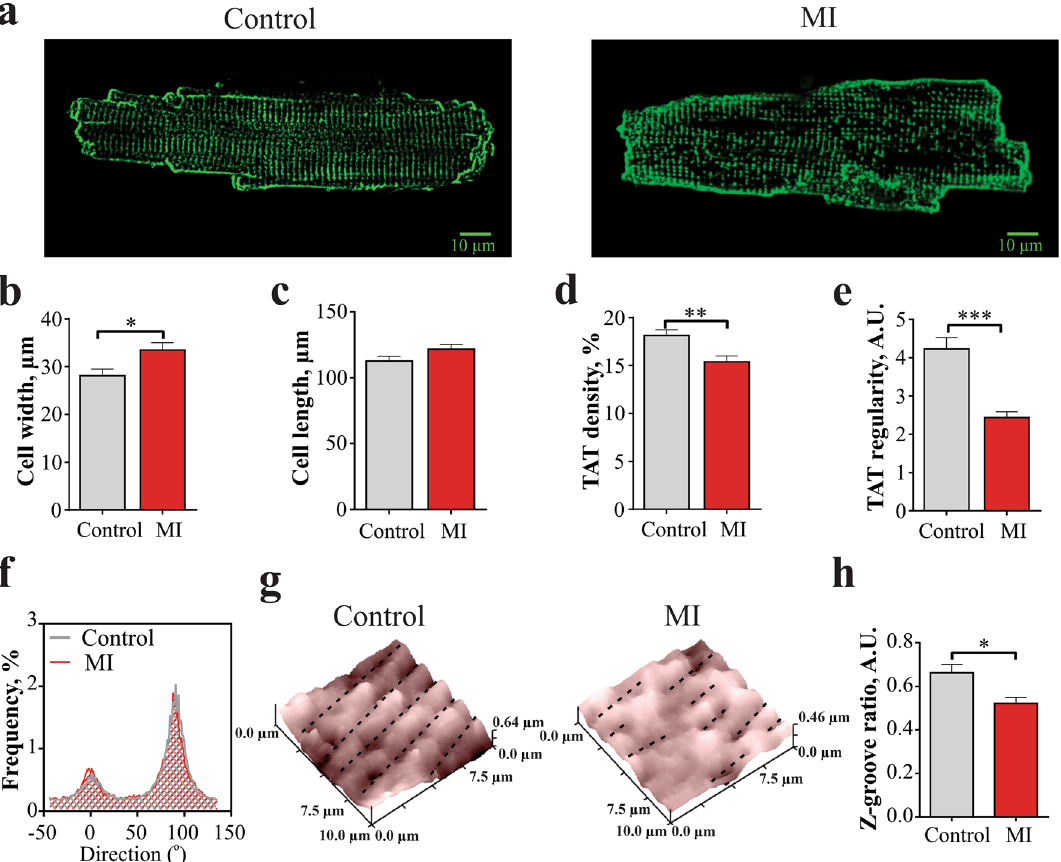
Figure 1. Structural changes of RVM membrane organization 16 weeks after MI. (a) Example images of control (left) and MI (right) RVM. (b) Average width and (c) length of RVM isolated from control and MI rats. Control n = 53 cells from 5 rats, MI n = 63 from 6 rats. *P < 0.05, by unpaired Student t test. ( d) TAT network average density and (e) TAT power of regularity measured in control and MI RVMs. Control n = 40 cells from 5 rats, MI n = 62 from 6 rats. **P < 0.01, ***P < 0.001, by unpaired Student t test. (f) Directionality histograms for the TAT network in control and MI RVMs. (g) Representative 10 × 10 µm surface scans of control and MI RVMs obtained by SICM. (h) Average z-groove ratio measured in control and MI RVMs. Control n = 26 cells from 6 rats, MI n = 37 from 5 rats. *P < 0.05 by unpaired Student t